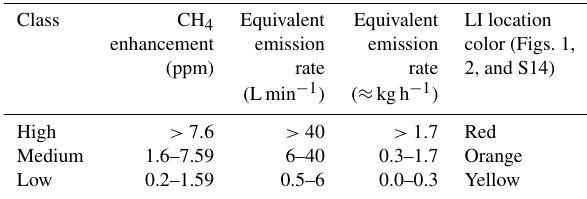
Table 1. Natural gas distribution network CH 4 emission